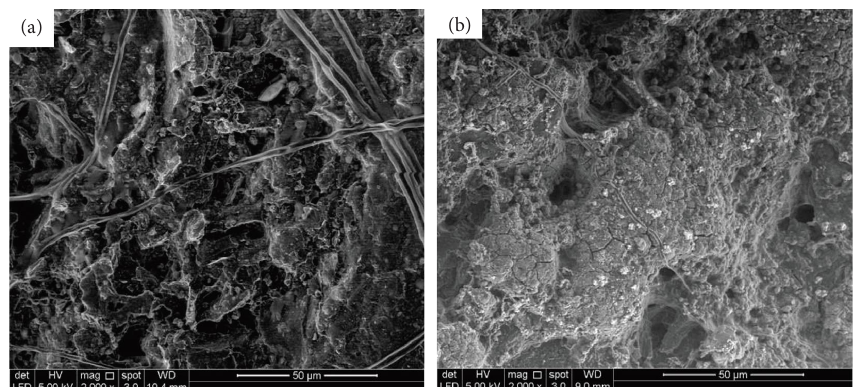
Figure 5: SEM images of (a) treated anode and (b) treated